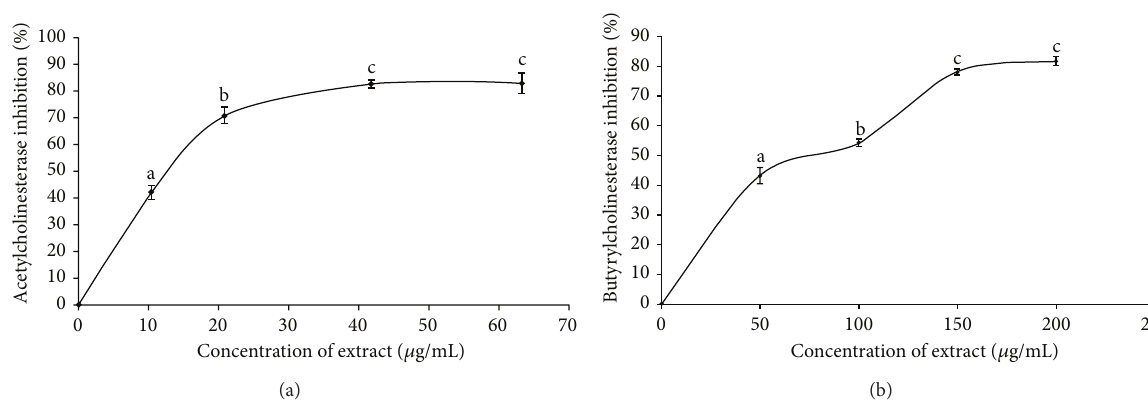
Figure 2: Anticholinesterase inhibitory activity, (a) acetylcholinesterase inhibitory activity and (b) butyrylcholinesterase inhibitory activity, of aqueous extract of Cola acuminata . Values represent means ± standard deviation of triplicate readings. Different letters above each concentration indicate significant differences ( 𝑃 < 0.05 ).